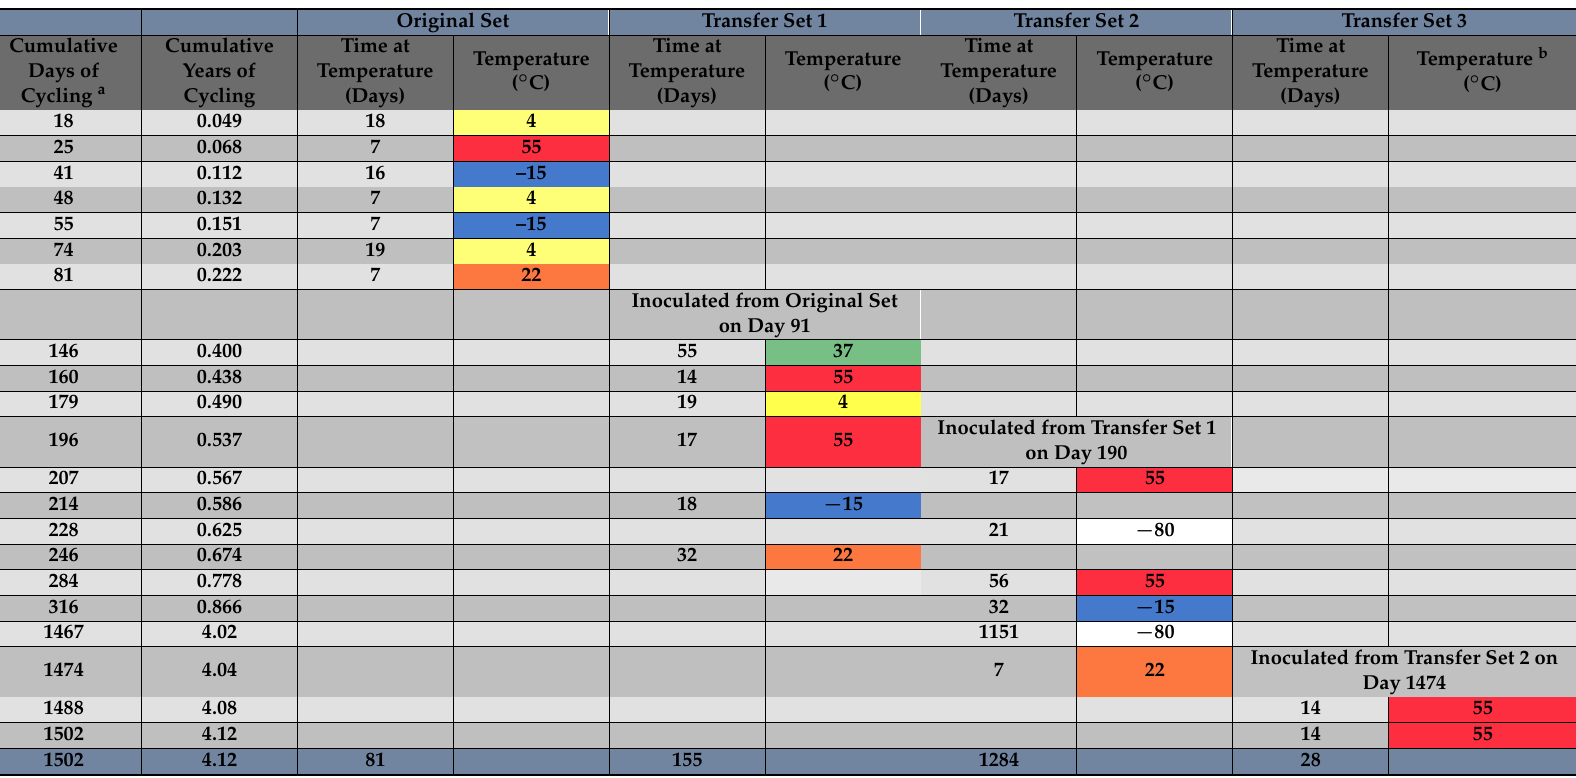
Table 4. Time intervals and temperatures for freeze/thaw cycling for Experiment 3 for Methanothermobacter wolfeii